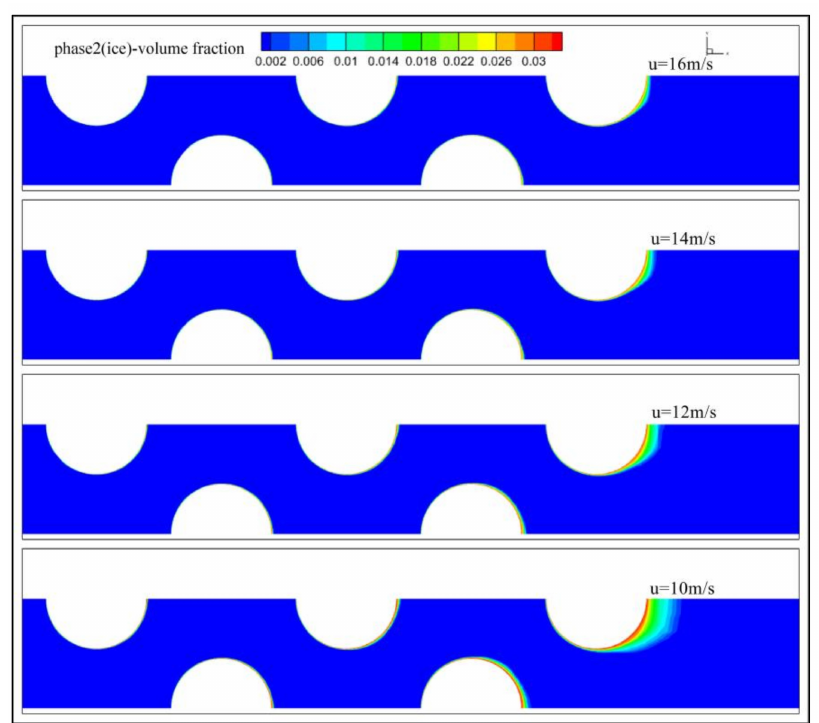
Figure 17. Frost morphology at different flow velocity (5th